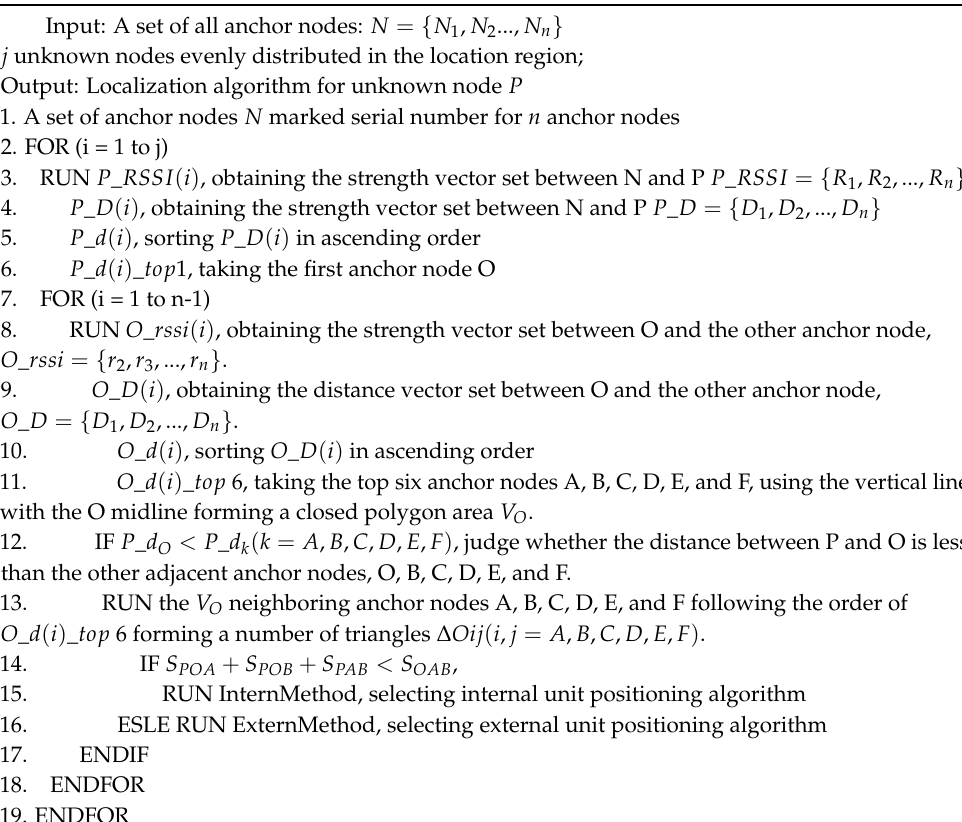
Figure 6. Results of triangle localization. Figure 5. Results of triangle